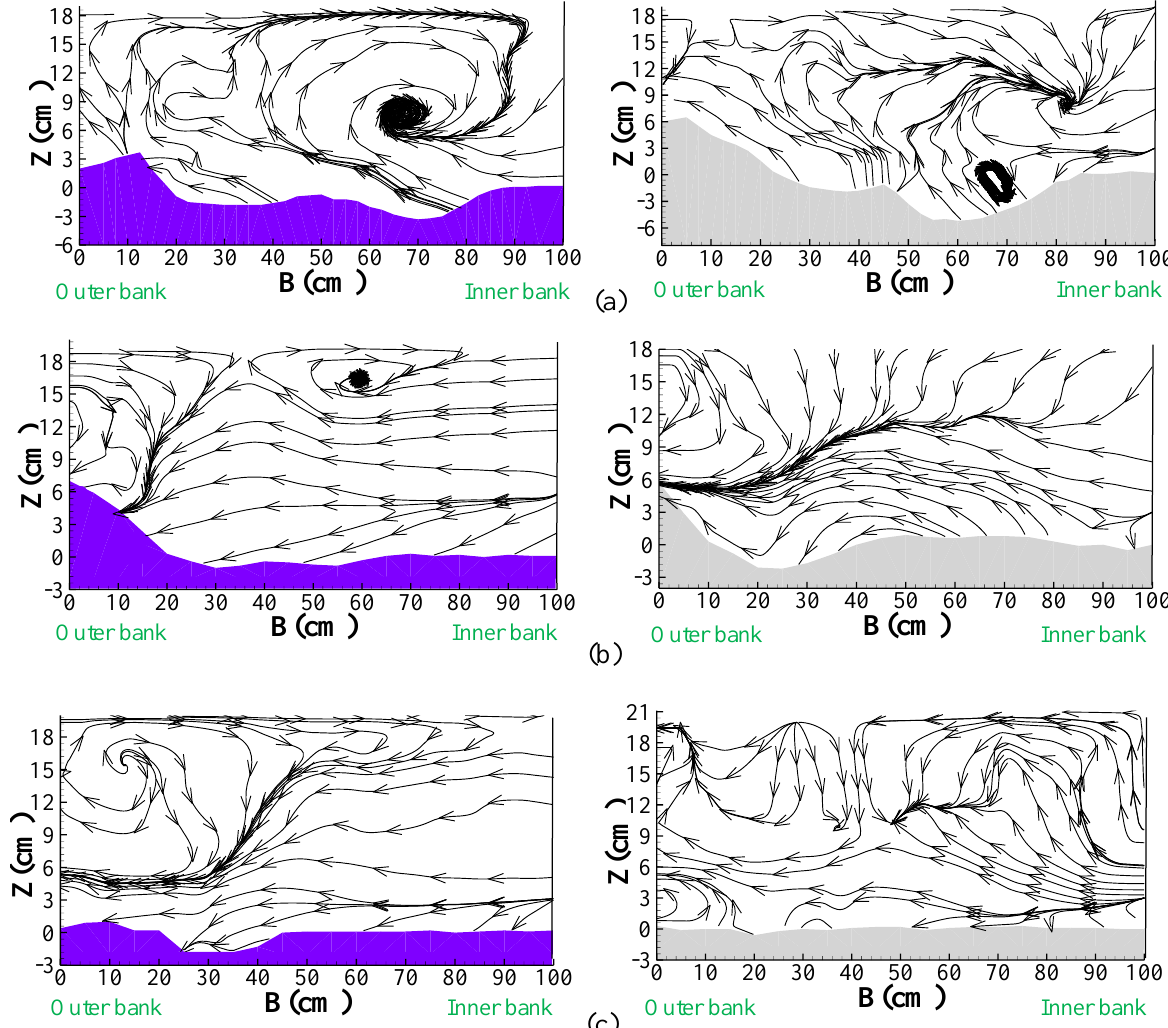
Figure 6. A view of the flow pattern at the a) 100, b) and c) 160 degree cross sections of the bend. (PFV experiment on the right, and PSV experiment on the